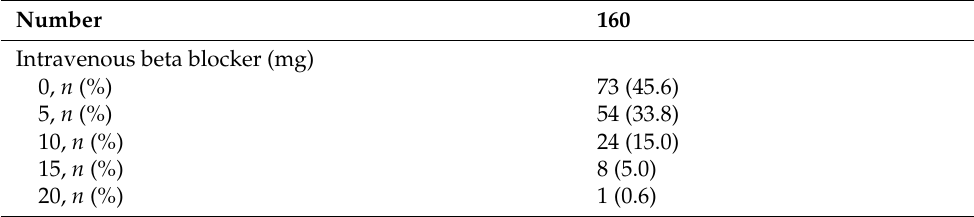
Table A2. Administered dose of